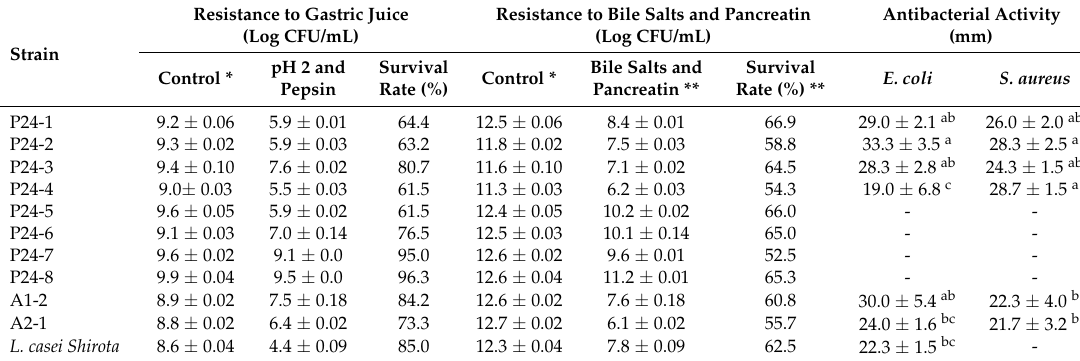
Table 2. Probiotic properties of isolated LAB.